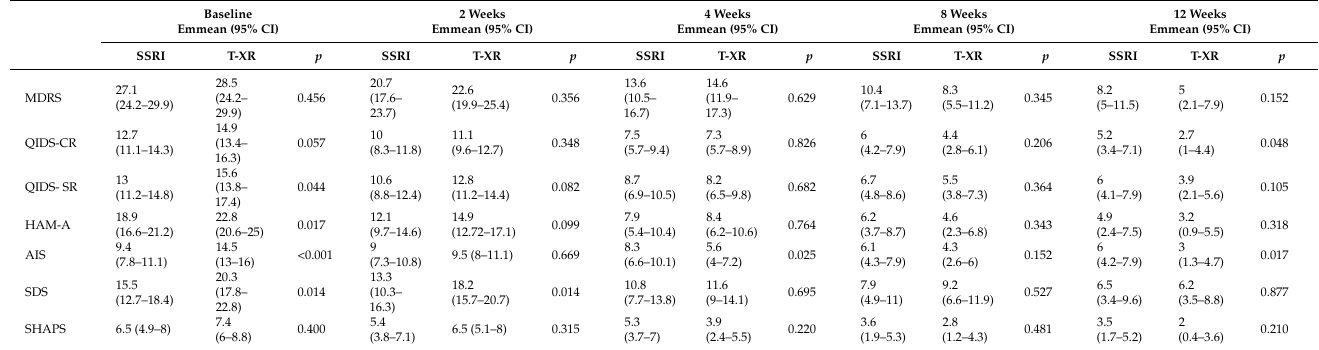
Table 3. Between-group comparisons for each time point. Values are presented as estimated marginal means with 95% confidence intervals. Emmean—estimated marginal mean; T-XR—trazodone extended- release formulation; MADRS—Montgomery–Åsberg Depression Rating Scale; HAM-A—Hamilton Anxiety Rating Scale; QIDS-CR—Quick Inventory of Depressive Symptomatology, clinician rating; QIDS-SR—Quick Inventory of Depressive Symptomatology, self rating; SHAPS—Snaith–Hamilton Plea- sure Scale; AIS—Athens Insomnia Scale; and CGI—Clinical Global Impression Scale.